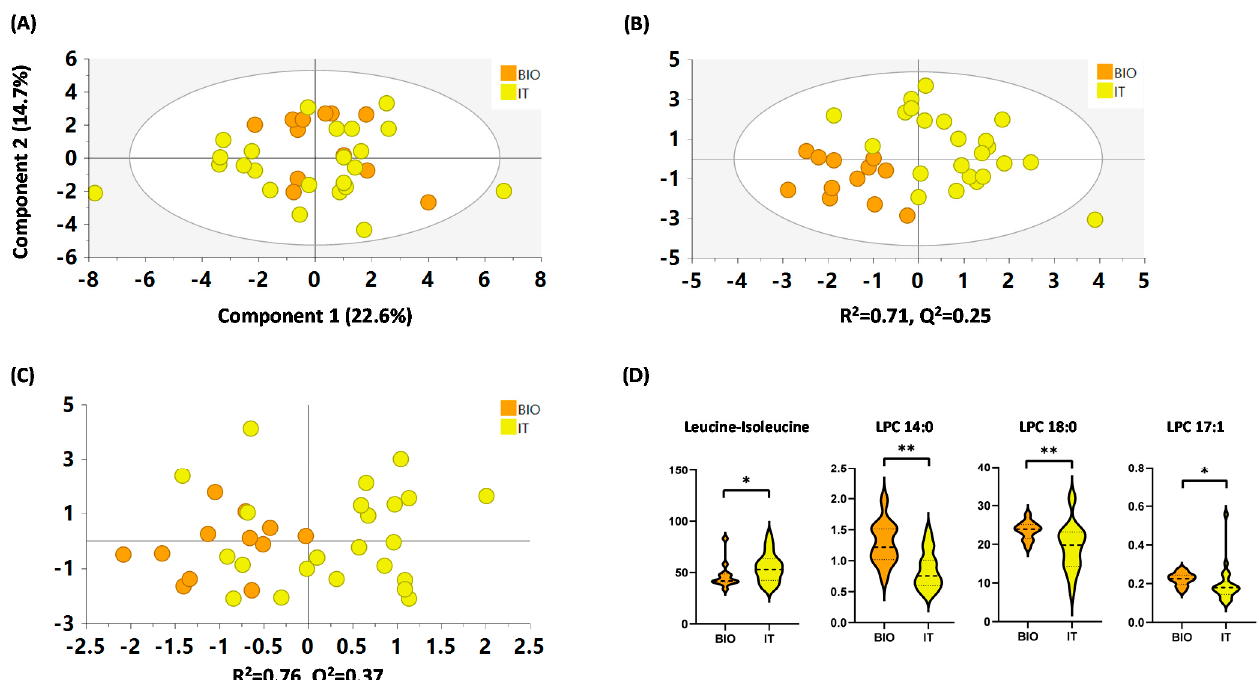
Figure 4. ( A ) PCA model, ( B ) PLS-DA model, and ( C ) CV-OPLS-DA model for IT vs. BIO comparison. Data were UV scaled. R 2 is the capability of the model to classify the samples; Q 2 is the capability of the model to predict the class of a new sample. ( D ) Comparison of significant metabolites by univariate statistics between the BIO and IT groups. Key: “BIO”: orange, “IT”: yellow. * p < 0.05; ** p < 0.01.